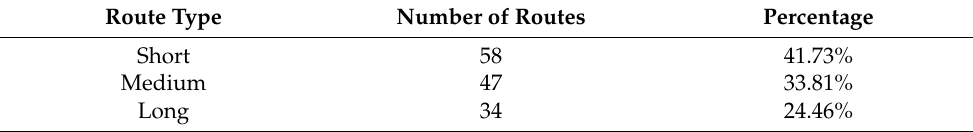
Table 6. Air corridor distribution on route type 1